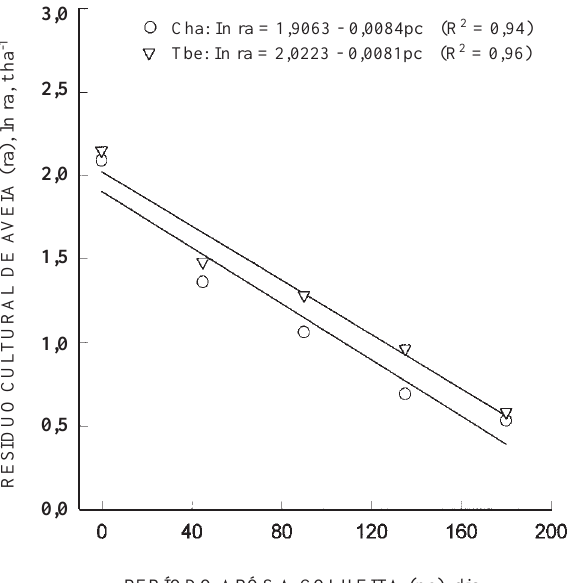
Figura 3. Temperaturas médias máximas (tma), e mínimas (tmi), mensais, ocorridas em Lages (Cha), e Lebon Régis (Tbe), no período de 180 dias após a dessecação/rolagem da cultura de aveia (pc), de outubro de 1995 a abril de